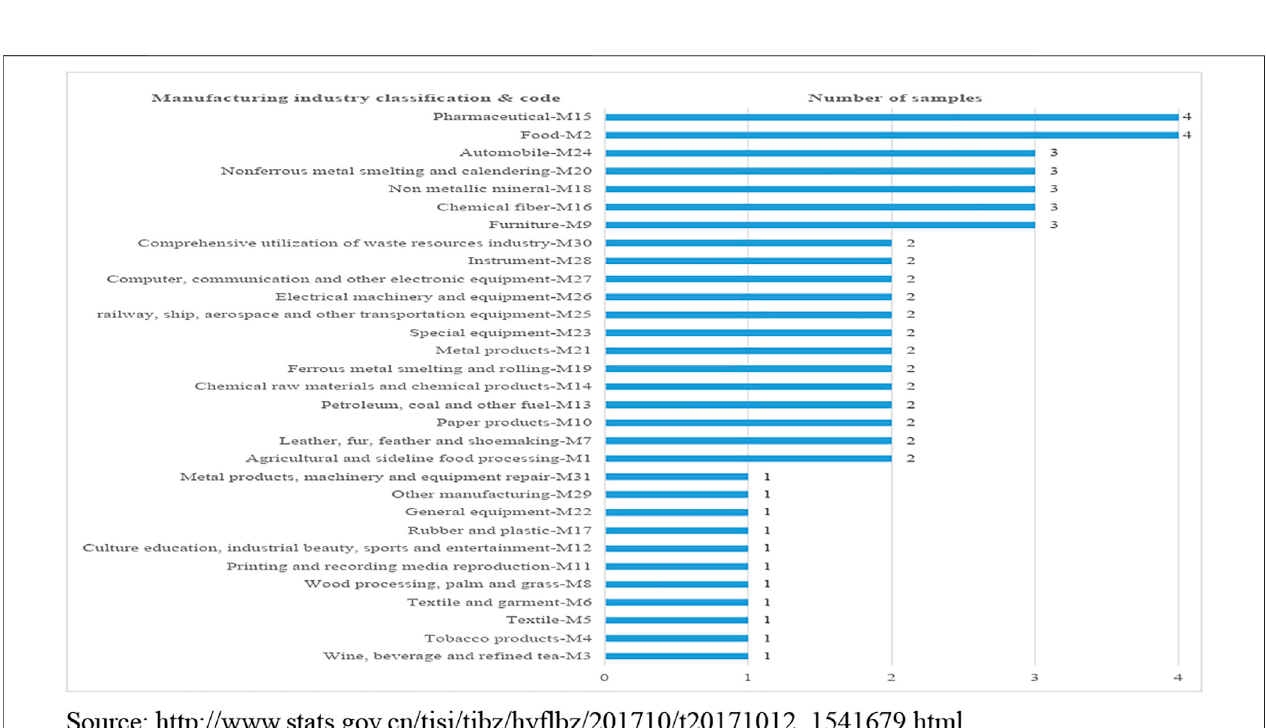
FIGURE 3 | Industry distribution statistics and No. of samples. Source: http://www.stats.gov.cn/tjsj/tjbz/hy fl bz/201710/t20171012_1541679.html.